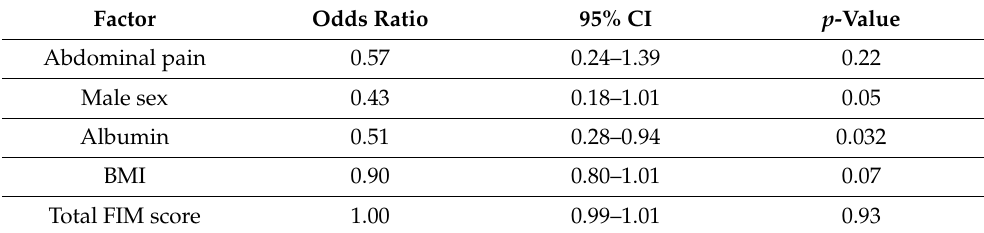
Table 2. Logistic regression model